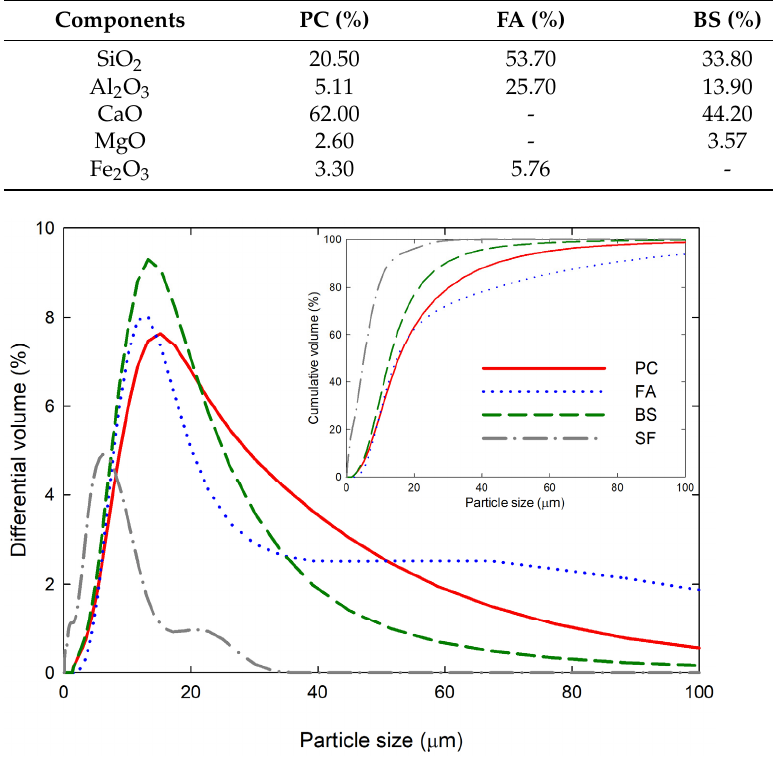
Table 2. Chemical compositions of cementitious materials.